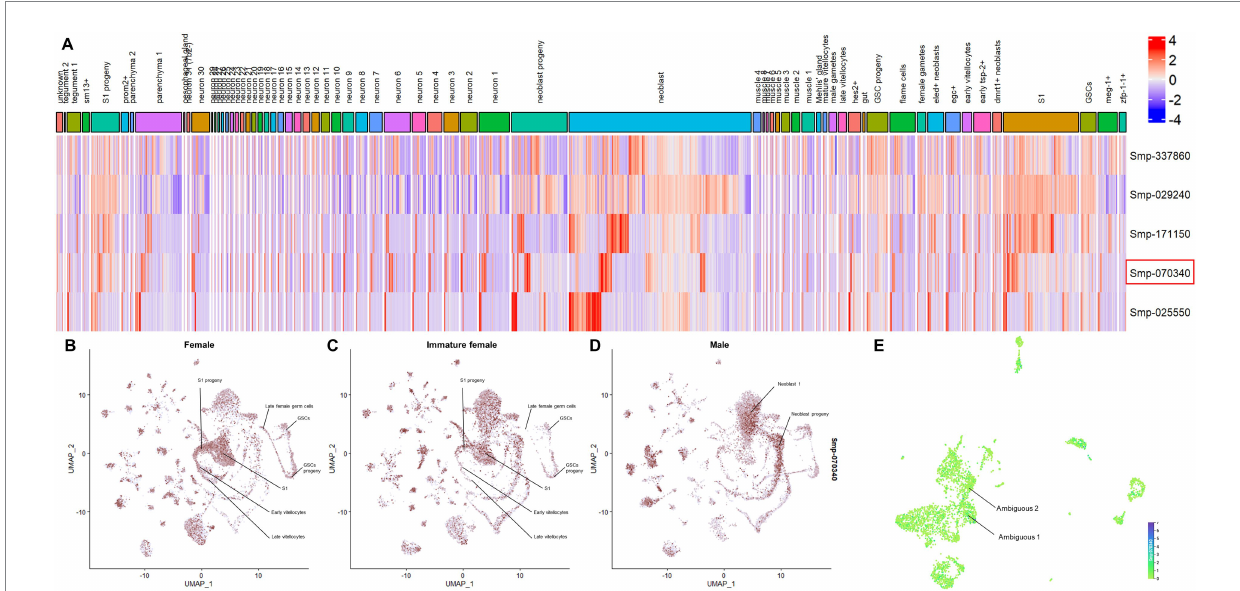
FIGURE 1 SmPRMTs expression in different cell types identified in Schistosoma mansoni adult worms. (A) SmPRMTs expression in different cell types identified in S. mansoni adult worms. The columns indicate the different cell types identified in adult worms and the lines represent the different SmPRMTs analyzed. The color scale indicates higher (red) or lower (blue) expression of transcripts. Sm carm 1 (Smp_070340) is highlighted by a red box. (B–D) UMAP projections depicting the expression profiles of Sm carm 1 in different cell clusters in (B) female, (C) immature female, and (D) male S. mansoni adult worms. Expression values are normalized and represented by colors (gray = not expressed, red = expressed). (E) UMAP projections depicting the expression profiles of Sm carm 1 in 13 transcriptionally distinct cell types in schistosomula. Expression values are normalized and represented by colors ranging from light green (not expressed) to purple (highly expressed).